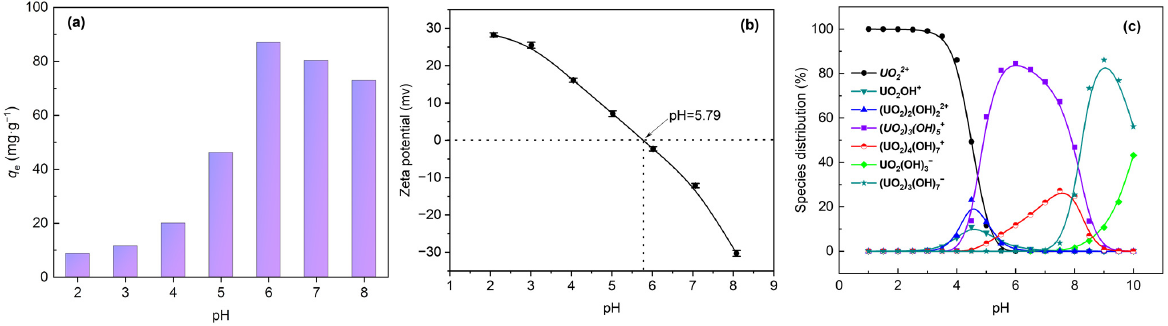
Figure 4. ( a ) The effect of initial pH on the capacity to adsorb U(VI) . ( b ) The zeta potential of IONPs@MAH- β -CD versus pH. ( c ) The morphology distribution of U(VI) at different pH.